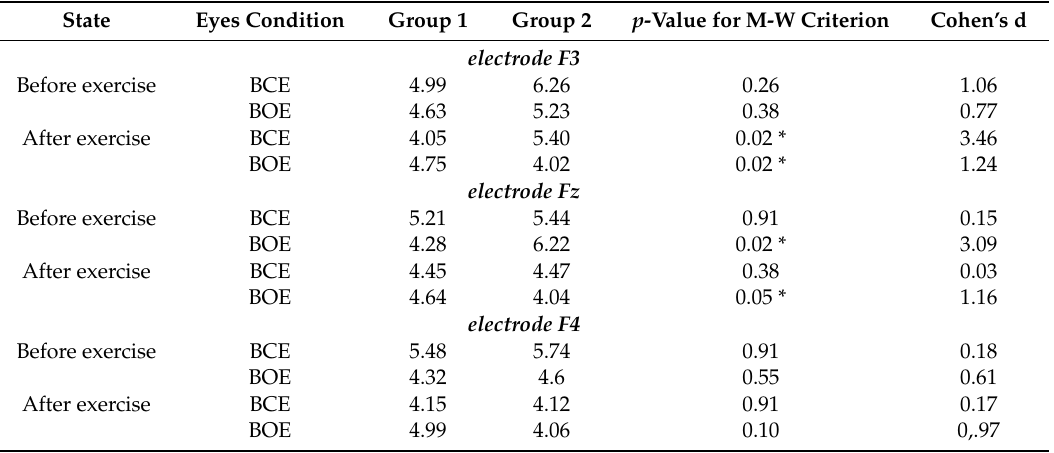
Table 4. Dynamics of theta rhythm before and after exercise in group 1 and group 2 (dominant frequency).